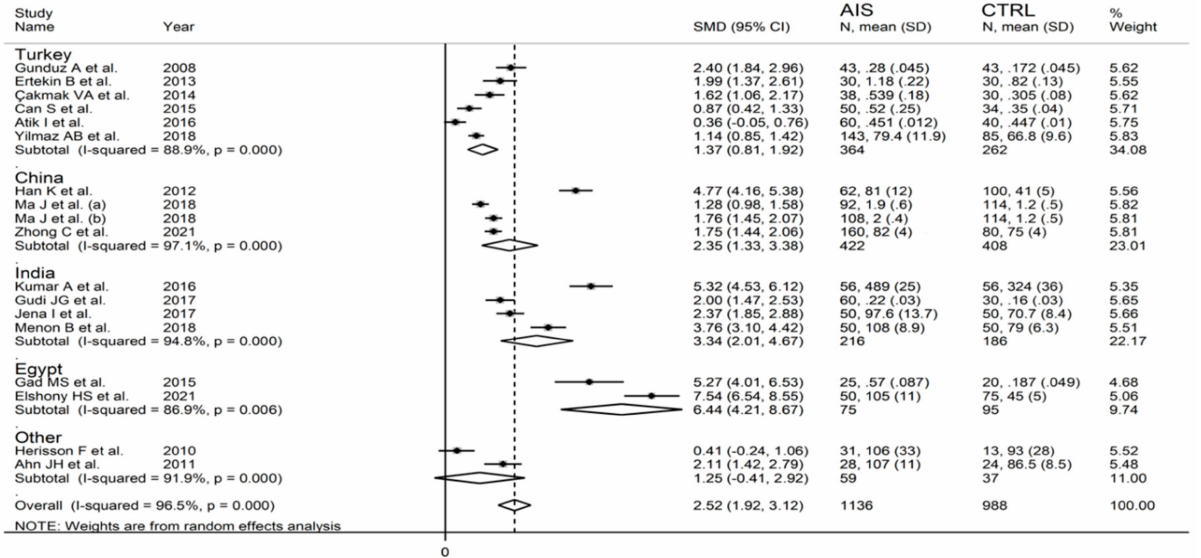
Figure 6. Forest plot of studies examining ischaemia-modified albumin in acute ischaemic stroke according to the country where the study was